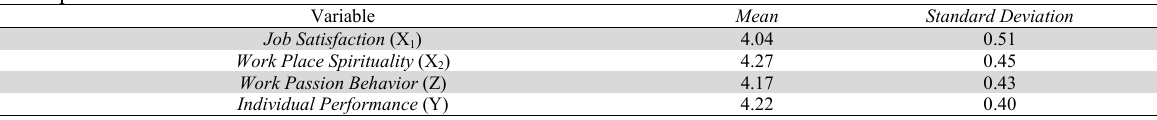
Descriptive statistics